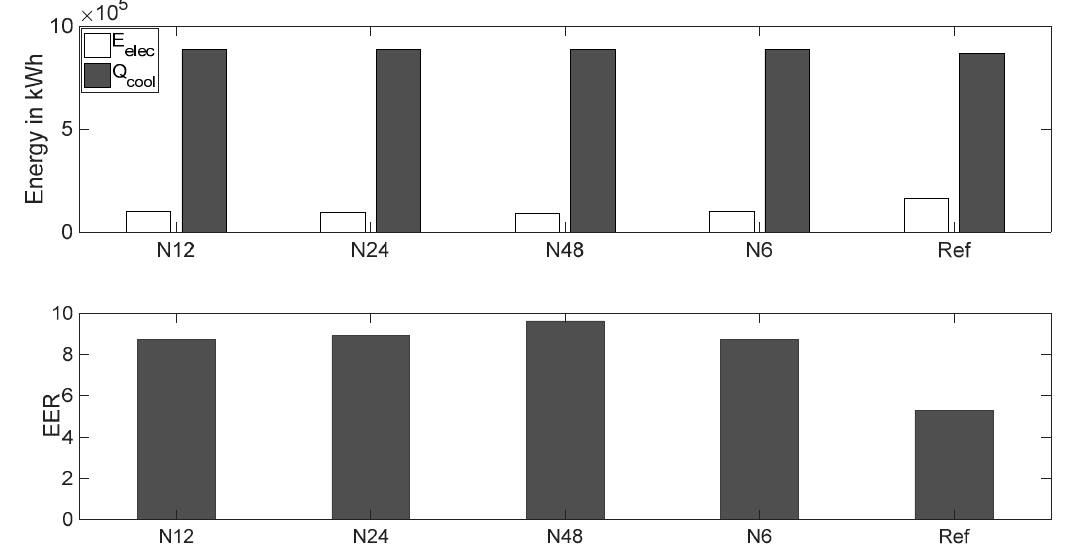
Figure 6. Energy savings and energy efficiency ratio (EER) comparison for varying prediction horizons .